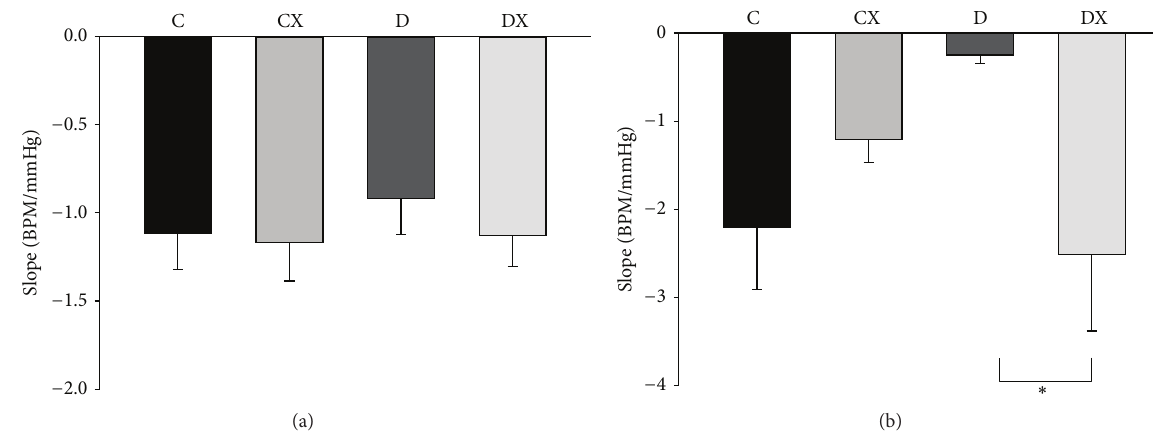
Figure5: (a)Tachycardiabaroreflexresponsesensitivitytosodiumnitroprussideatweek10: C,sedentarycontrol( 𝑛 = 7 );CX,controlexercise ( 𝑛 = 6 ); D, sedentary T1DM ( 𝑛 = 6 ); DX, T1DM exercise ( 𝑛 = 10 ). (b) Bradycardia baroreflex response to phenylephrine at week 10: C ( 𝑛 = 7 ); CX ( 𝑛 = 5 ); D ( 𝑛 = 7 ); DX ( 𝑛 = 10 ). ∗ Significantly different groups ( 𝑝 < 0.05 ). Data are mean ± SE.